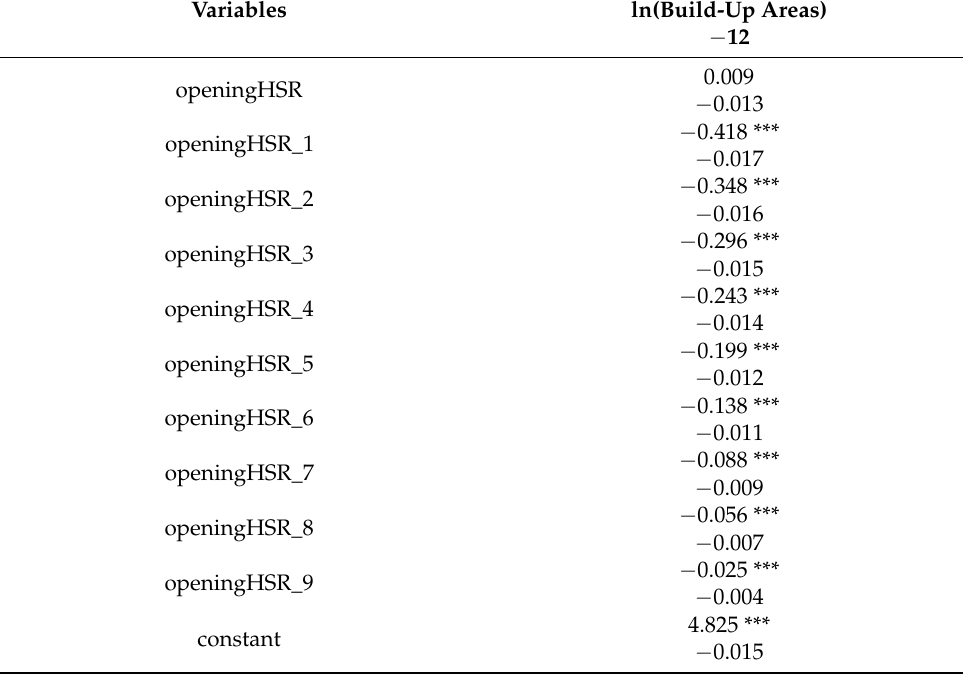
Table 5. The result of robustness